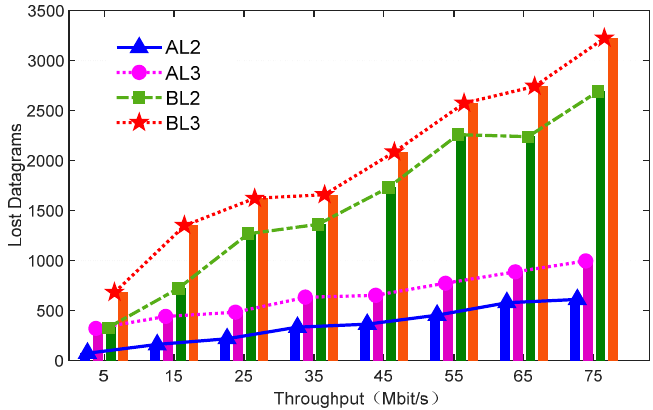
Figure 8. The number of consecutive packet losses during recovery time.